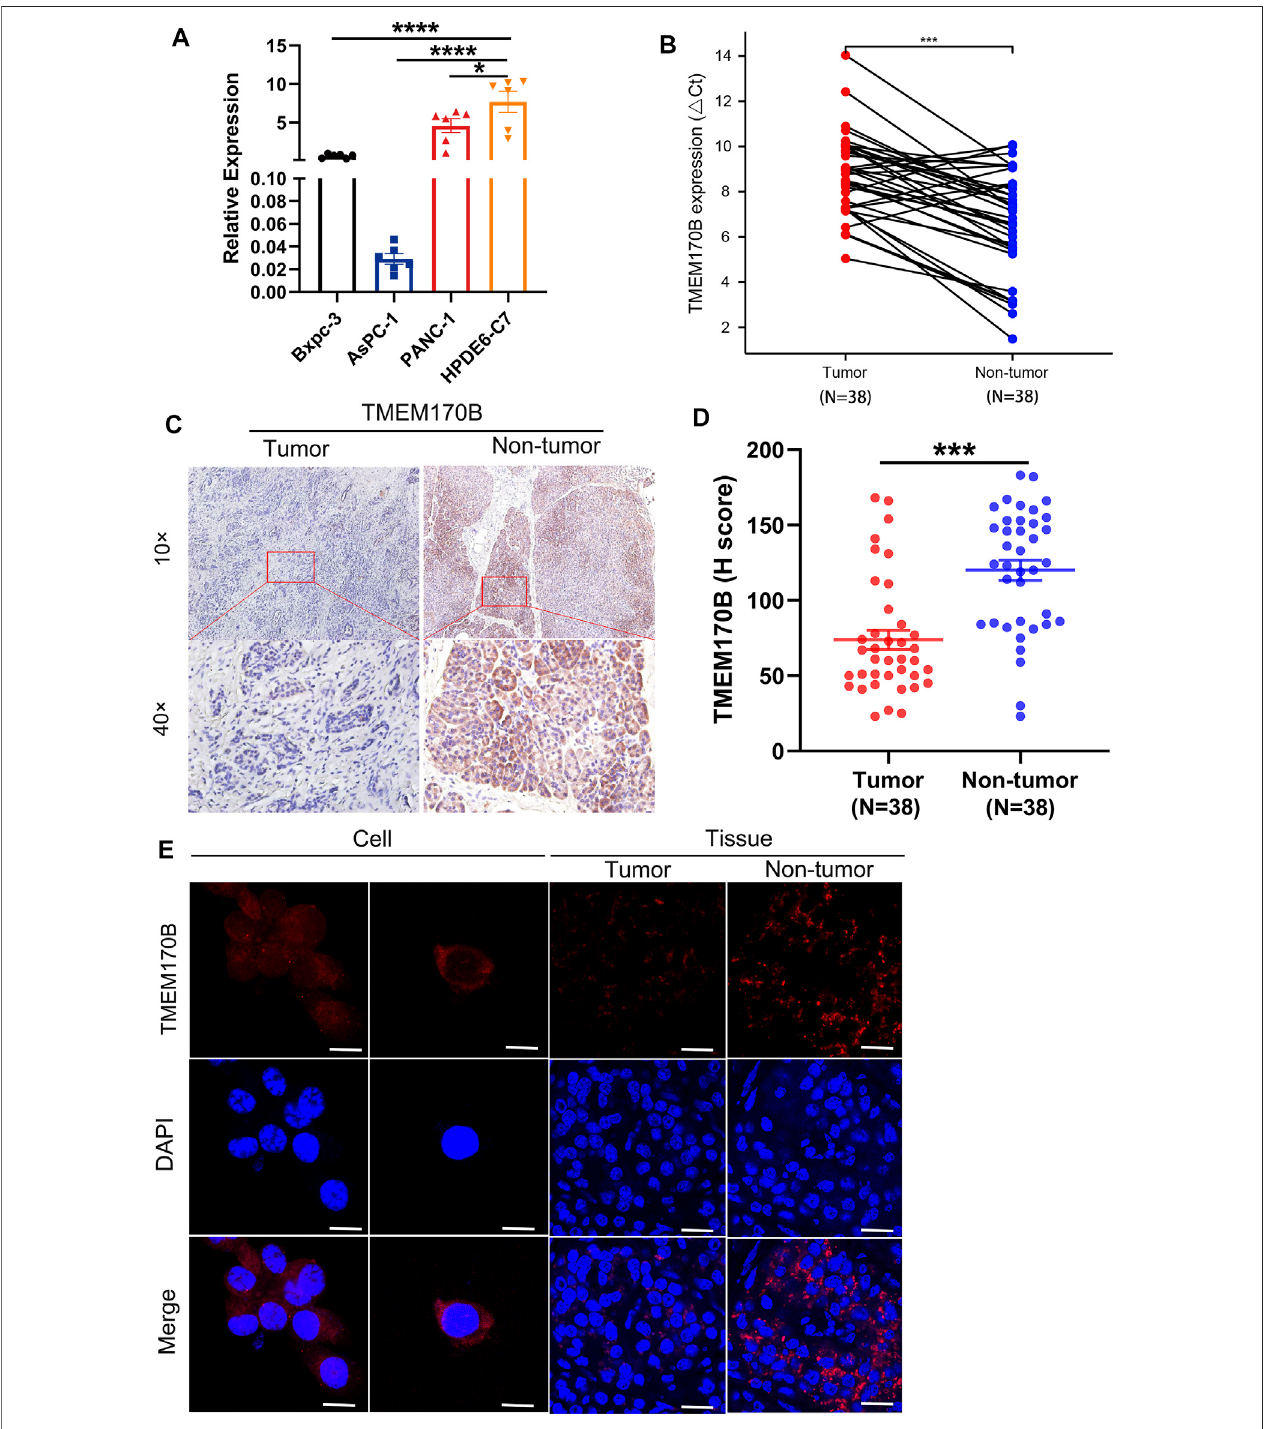
FIGURE 2 | TMEM170B expression was downregulated in human pancreatic cancer cell lines and tissues. (A) TMEM170B mRNA levels were low in pancreatic cancer cell lines. (B) Real-time PCR analysis of TMEM170B mRNA expression in 38 pairs of pancreatic adenocarcinoma (PAAD) tissue and paired nontumor tissue. (C) Representative immunohistochemistry (IHC) images of TMEM170B in 38 pairs of matched tumor tissues and adjacent nontumor tissues. (D) IHC quanti fi cation was performed using ImageJ software, and TMEM170B protein expression in PAAD tissues was lower than that in nontumor tissues. (E) The subcellular localization of TMEM170B was analyzed with immunostaining (cell: scale bar, 20 μ m; tissue: scale bar, 30 μ m); ns: not signi fi cant. * p < 0.05; ** p < 0.01; *** p < 0.001.